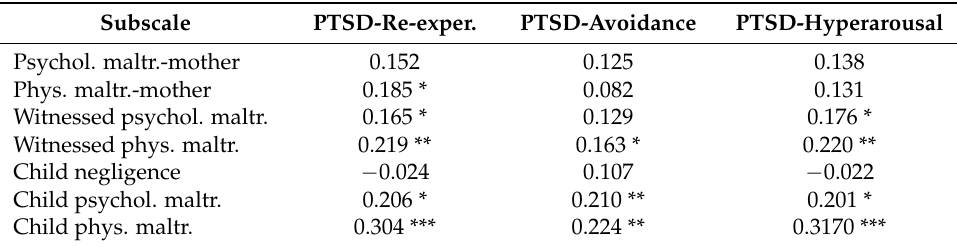
Table 5. Pearson correlation matrix of child PTSD symptoms and child–mother maltreatment. Subscale PTSD-Re-exper.